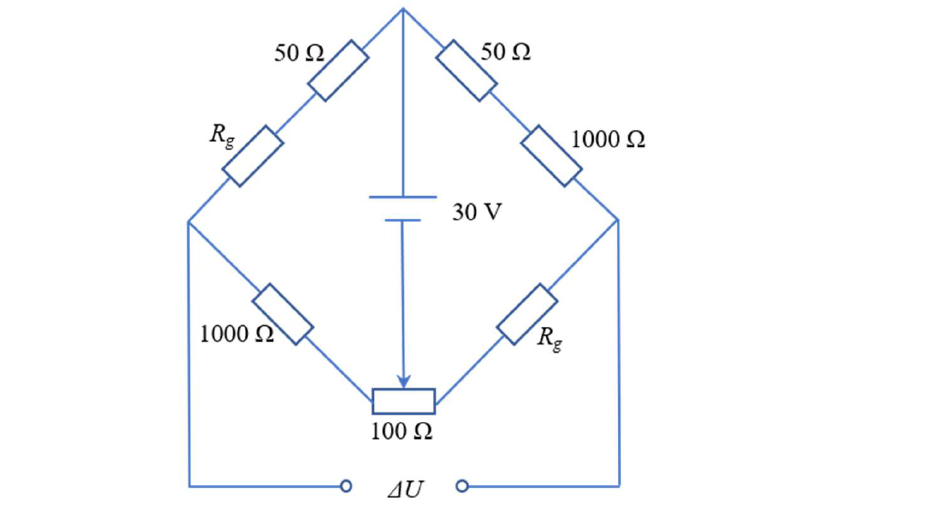
Figure 3. Wheatstone bridge adopted in the test.